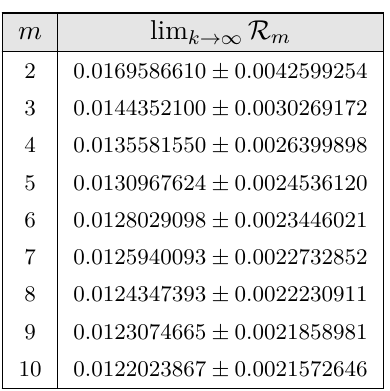
Table 15. The k → ∞ values of the Rényi entropies associated with the state | 6 3 # T 2 , 2 i .